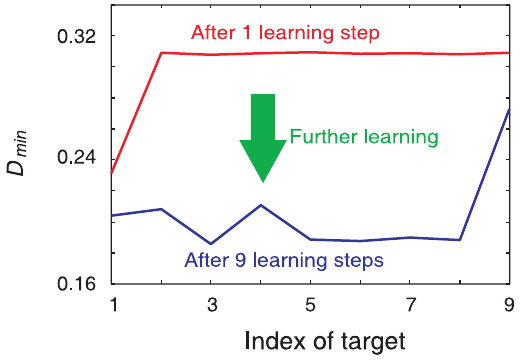
Figure 11. Change in the minimum distance between the activity and the target during the learning process. D min ( J n ) gives the minimum distance between the neural activity X and the target J n , averaged over phase space in the absence of inputs. Here, X and J n include the activity of the neurons in the output and hidden layers. The target J becomes identical to the neural activity pattern after convergence to target j in the output layer. D min ( J n ) is defined as D 1000 initial conditions for the neural activities f x i g . The red and blue lines represent D min ( J n ) about all targets ( n ~ 1,2, ... ,9) after learning one and nine (I/O) mappings, respectively. Only the minimum distance between the neural activity and the learned target decreases.